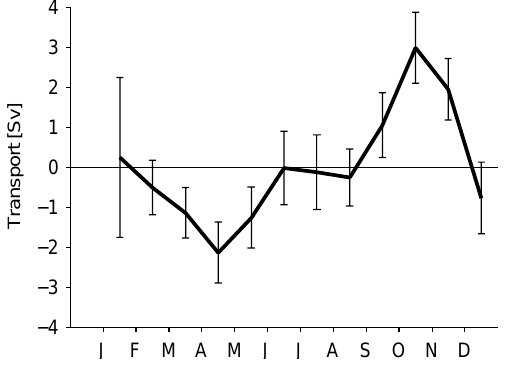
Fig. 15. Monthly-mean anomalies of the eastern-boundary contri- bution to the AMOC at 26.5 ◦ N ( 9 EBH deviations of the monthly